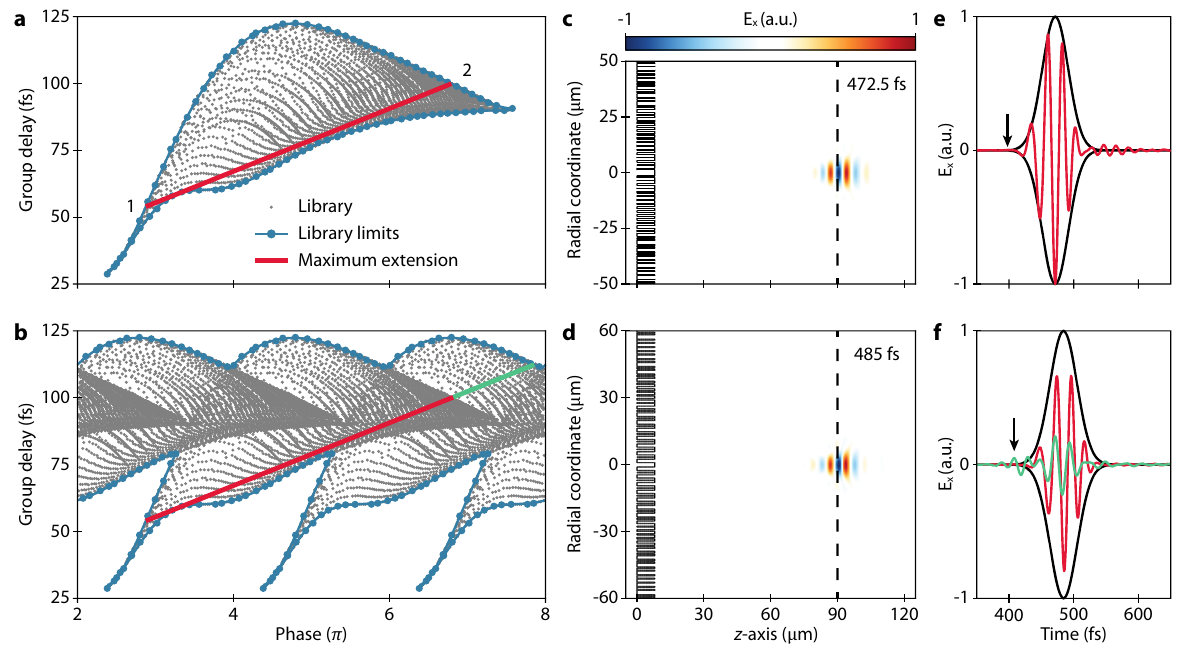
Figure 2: Framework for designing an achromatic metalens. (a)Phaseandgroupdelayforallelementsinthepresentedlibrary,distinctivebythegreydots,withthebluelinesdefiningtheupperandlower boundaryof thelibrary andthe redline displayingthe maximalphaserange thatthelibrary can cover.(b)The samelibrary is duplicatedevery 2 π enablingalongerphaserange,i.e.,redlineplustheadditionalgreenline.(c,d)Simulatednormalizedelectric fi eld( x -component)ofa25fs opticalpulseasitisfocusedatthefocalpoint( f =90 μ m)withthea-typemetalensdesign(NA=0.49)andb-typemetalensdesign(NA=0.55), respectively. (e, f) Simulated normalized electric fi eld ( x -component) at the focal point as a function of time for the a- and b-type metalens design, respectively. The pulse in (f) is split into the component attributions of the red and green line from